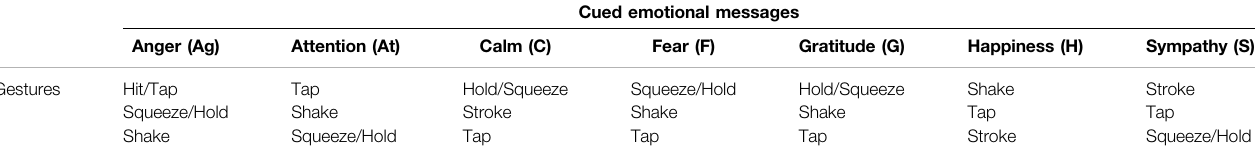
TABLE 1 | Available gestures for each cued emotional message in touch communication